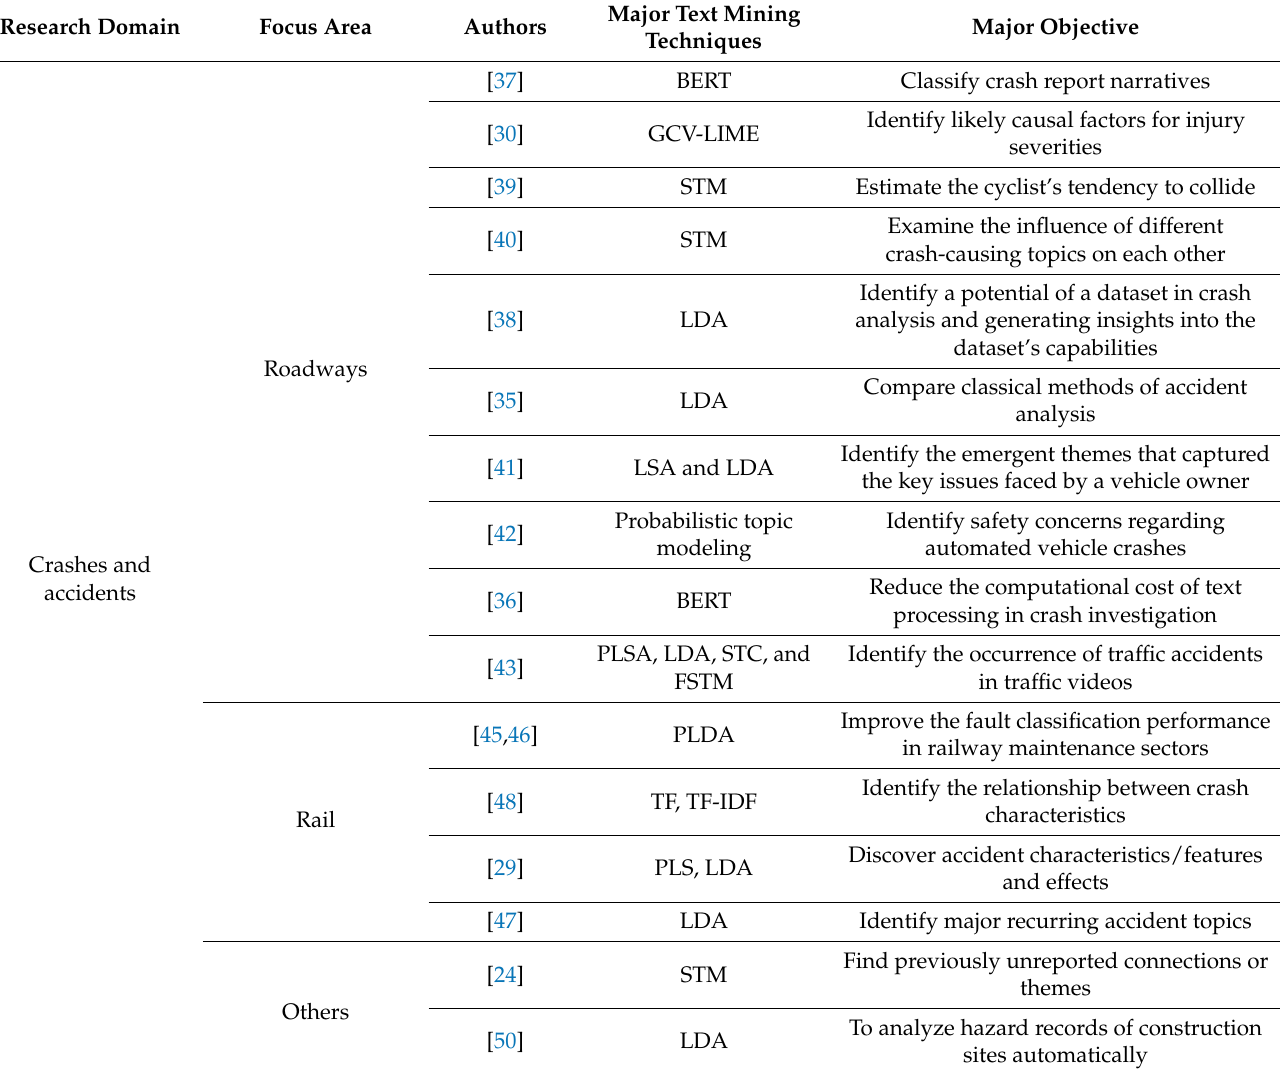
Table 1. Summary of key literature reviewed in this